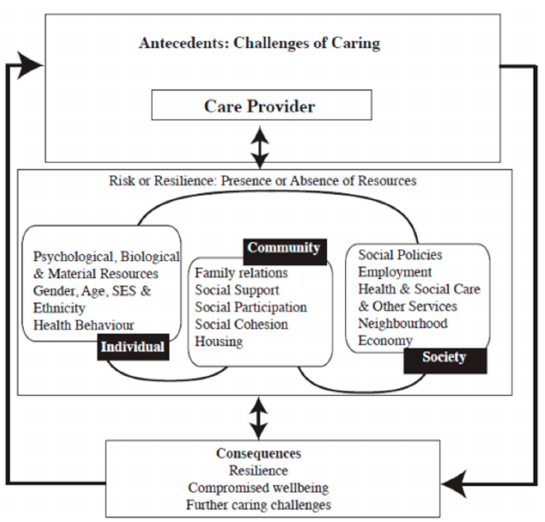
Figure 1. Ecological resilience framework applied to care providers (Windle & Bennett, 2011) [23].